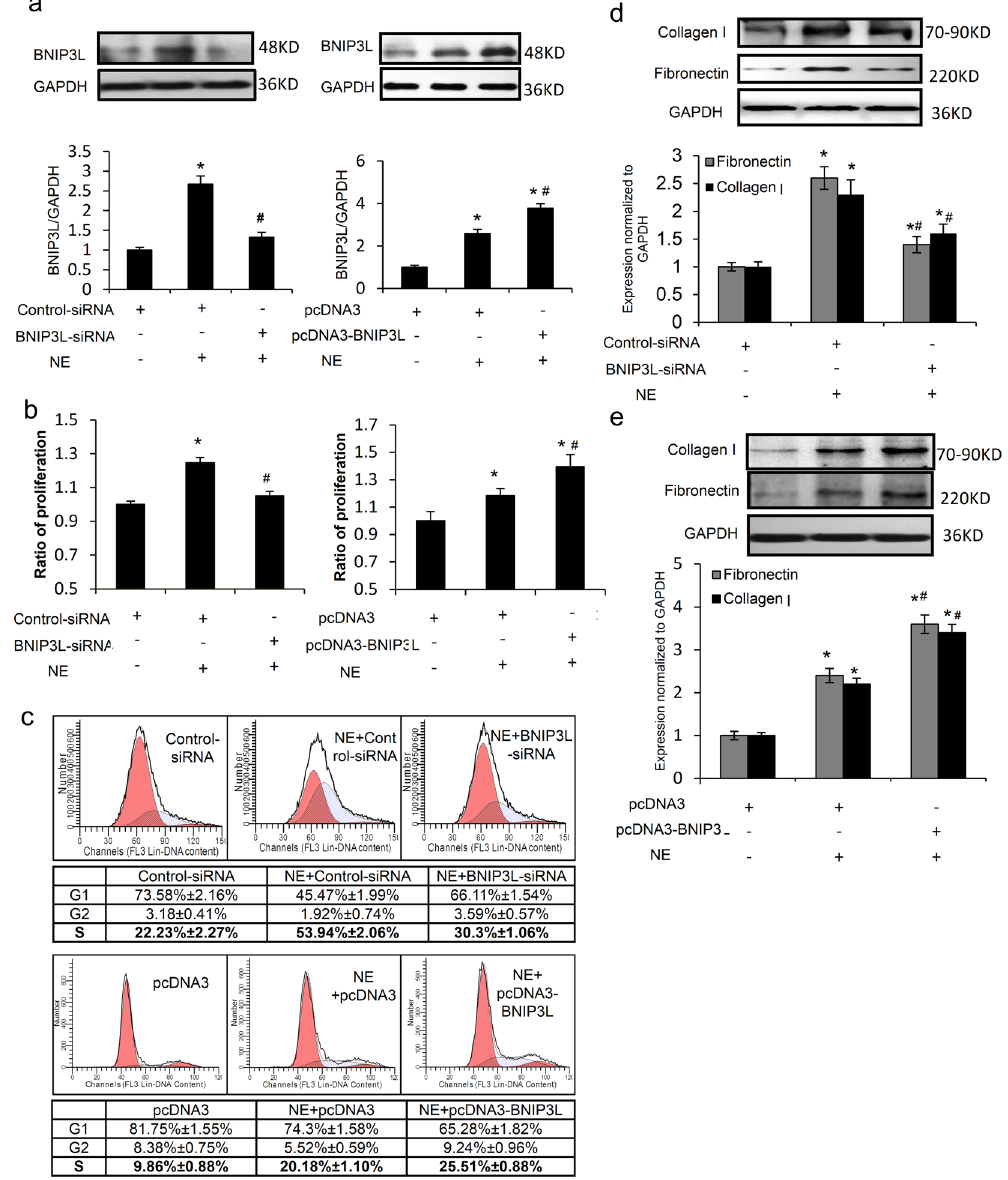
Figure 5. The roles of BNIP3L in NE-treated CFs. Neonatal rat CFs were treated with NE after transfection with the BNIP3L and BNIP3L-siRNA adenoviruses. ( a ) Western blot analysis showing the effects of the transfection on NE-induced BNIP3L expression. ( b ) Proliferation was measured using the MTT assay. ( c ) Cell cycle stage was determined by FACS, and the data were analyzed using the ModFit program. ( d,e ) Western blot analysis showing the effects of BNIP3L on fibronectin and collagen I expression. Each experiment repeated three times. Data shown are mean ± SD, * P < 0.05 vs. Control, # P < 0.05 vs.